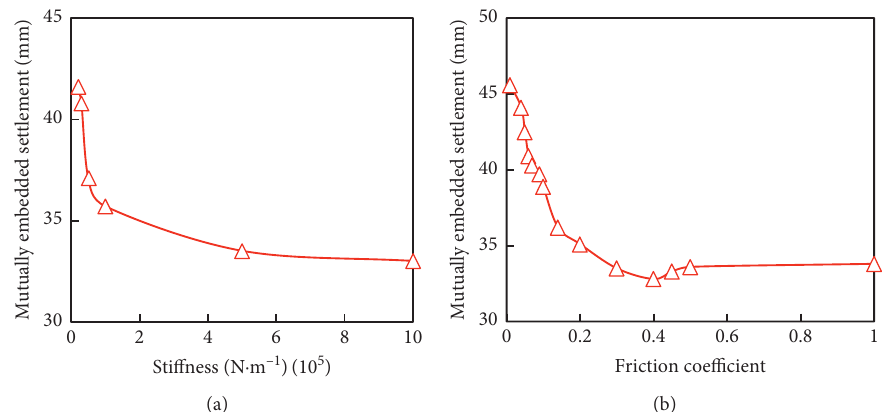
Figure 5: Relation curves of mutually embedded settlement with contact stiffness and friction coefficient. (a) Relation curves between mutually embedded settlement and contact stiffness. (b) Relation curves between mutually embedded settlement and friction coefficient.